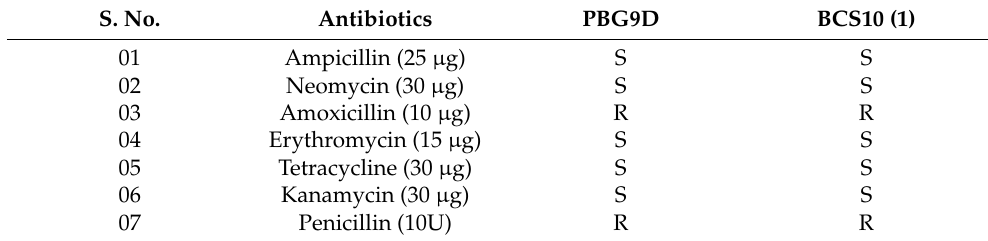
Table 3. Antibiotic susceptibility of selected bacterial isolates.